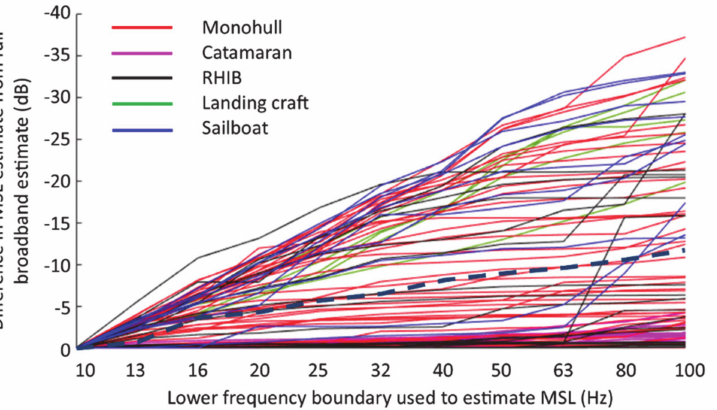
Figure 5. Reduction in MSL estimates for 95 example vessels and speeds (vessel type denoted by colours shown in the legend) when comparing the full broadband estimate (10 Hz to 63 kHz) to estimates made with a different low-frequency boundary (up to 100 Hz). Data taken from Wladichuk et al. [51]. Dashed, thick grey line denotes the mean of all vessels.